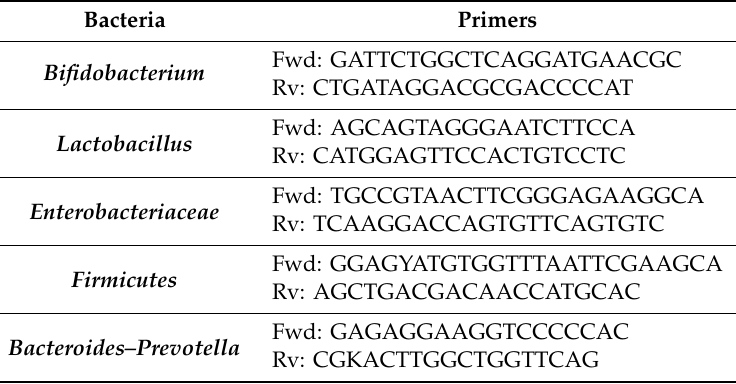
Table 1. 16S rRNA gene-targeted group-specific primers used in this study according to S á nchez-Moya et al. [28] and Gonz á lez-Berm ú dez et al.